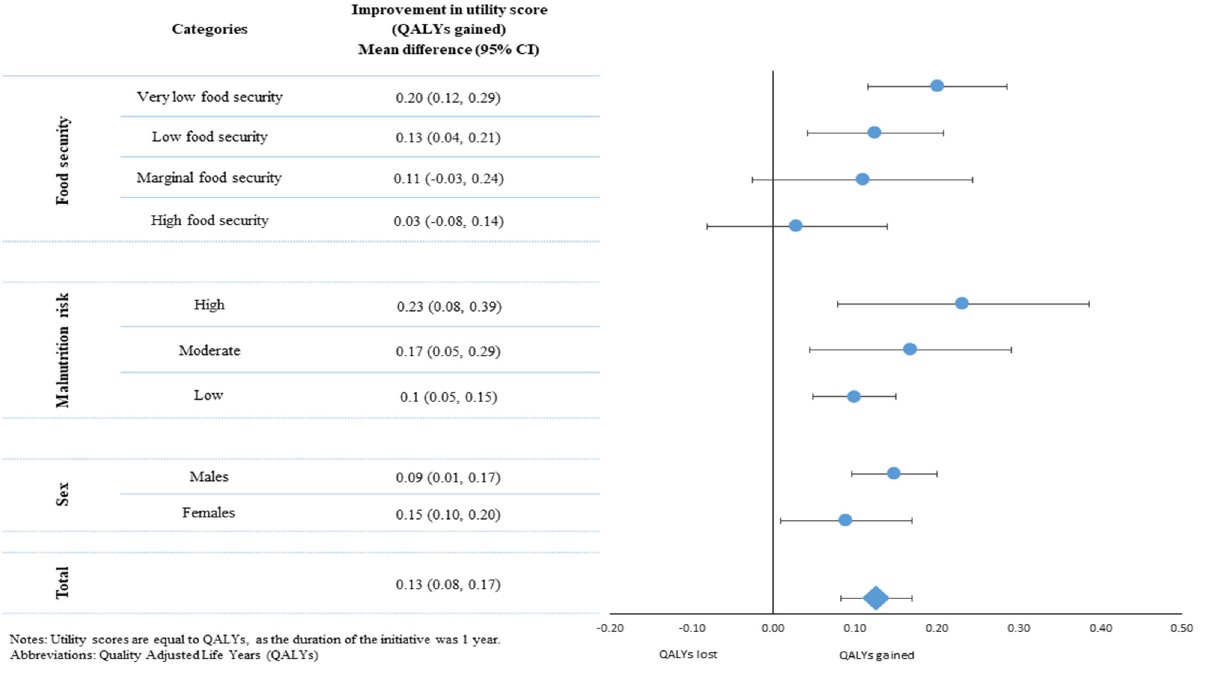
Figure 1. Mean differences in utility values and QALYs gained by the total sample as well as according to sex, food insecurity status, and malnutrition risk classification.